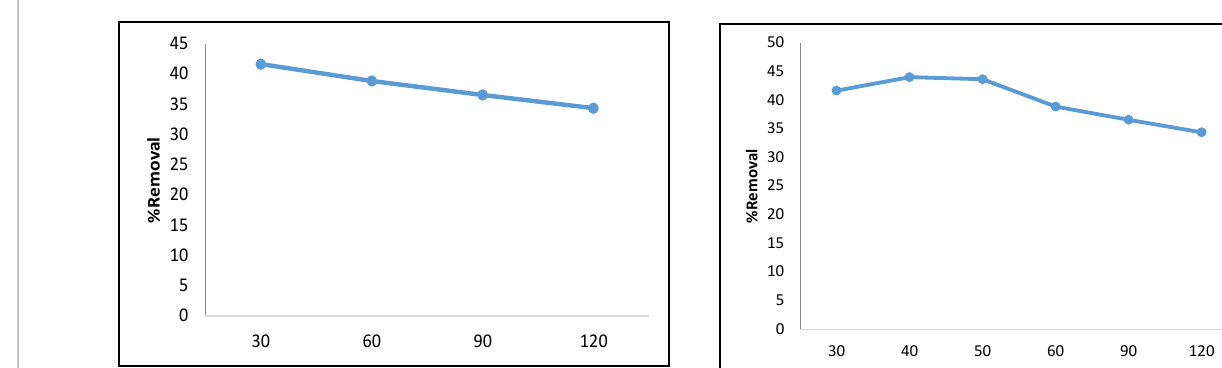
Fig. 5. The removal efficiency of Cr (VI) by ferrous sulfate at different contact times (30, 40,50,60,90,and 120 Figure 4. The removal efficiency of Cr (VI) by ferrous sulfate